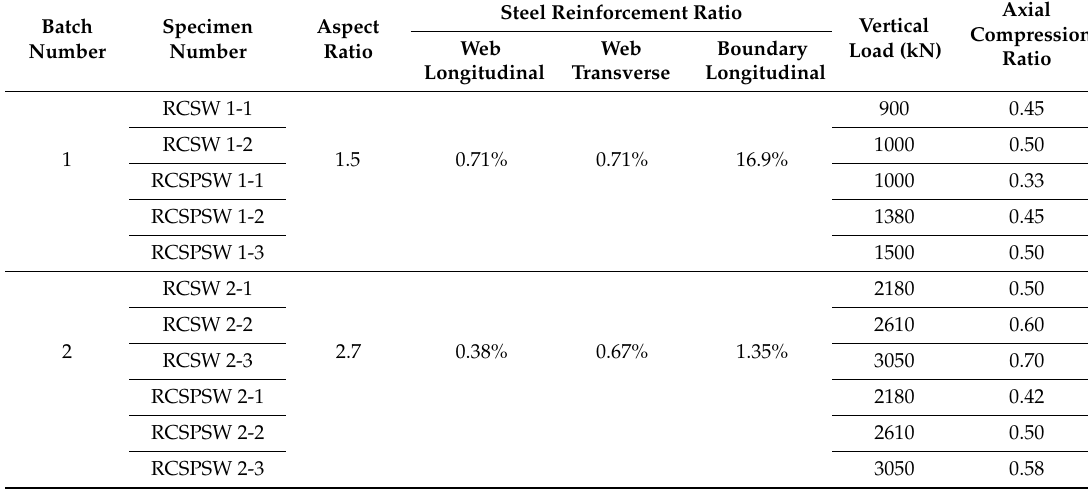
Table 1. Test Specimen Configurations.